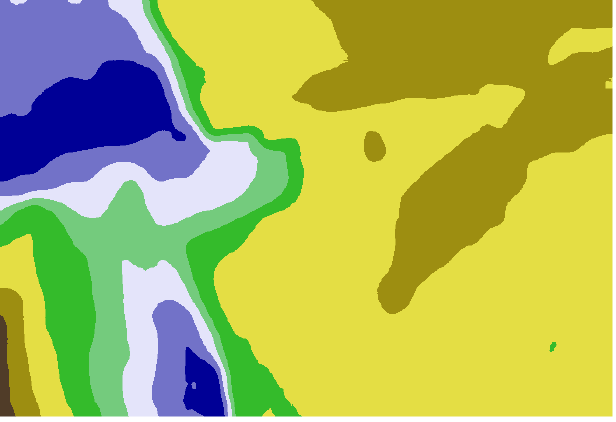
Figure 11. Optical cuts detected on multifocal image of limestone (two images in the series—see Figure 3). The software was written by the first author of this paper. Taken from [45].